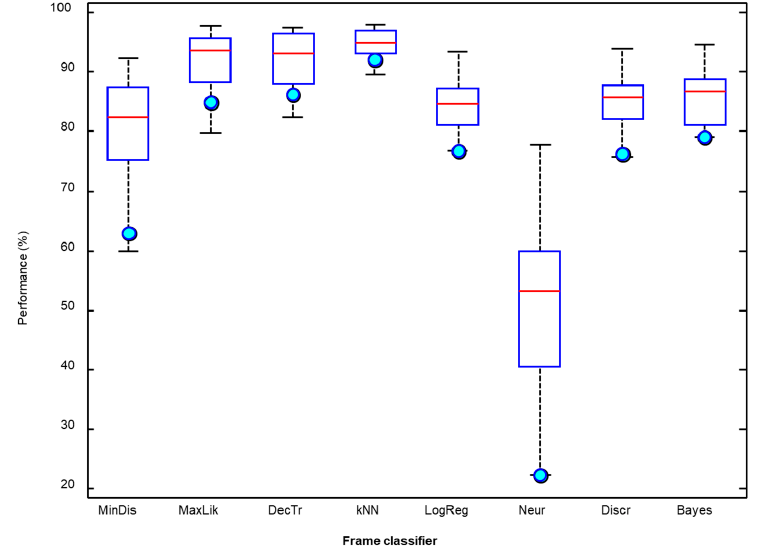
Figure 12. Boxplot of the performance metrics for the procedure of counting frames.